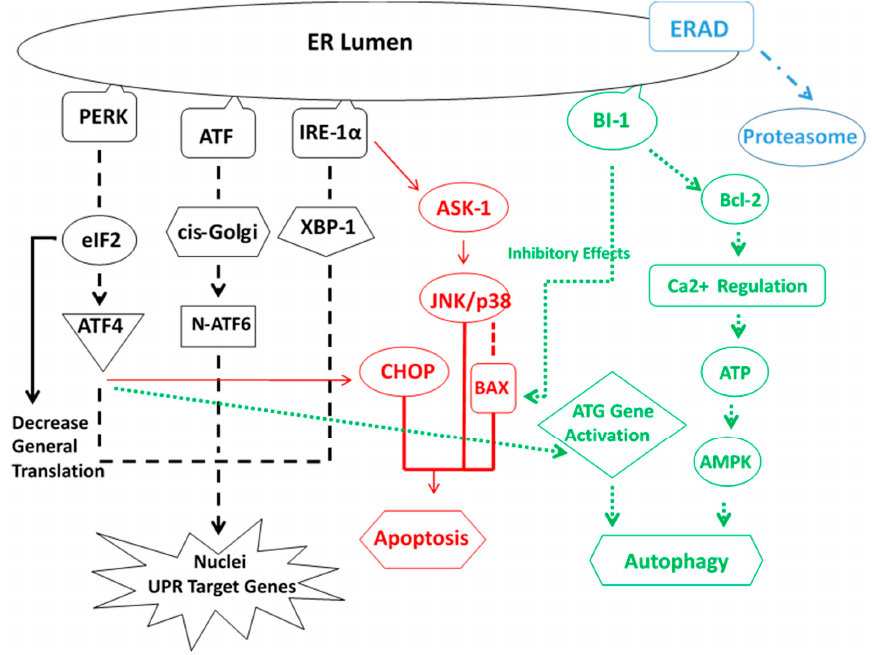
Figure 3. Cross ‐ reaction of cycloprotective pathways involved in protein quality control activated by ER stress. ERAD: endoplasmic reticulum associated degradation.